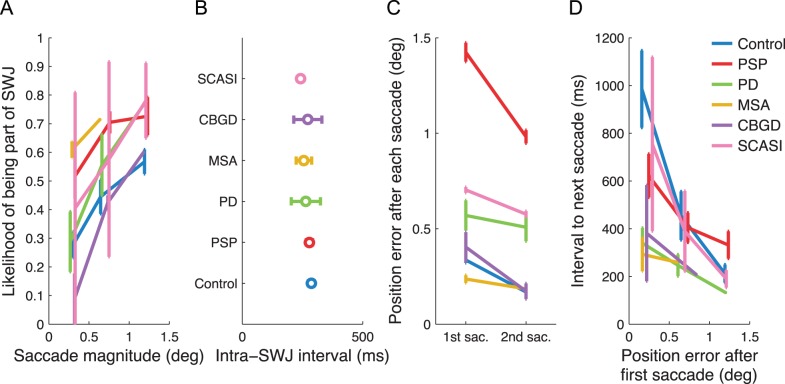
A common square-wave coupling mechanism.A) Correlation between saccade size and likelihood of being part of a SWJ. B) Intra-SWJ intervals across groups. C) Position error (see Methods for details) at the end of the first versus second saccade in a SWJ. D) Relationship between the estimated position error at the end of each saccade and the inter-saccadic interval to the next saccade. Error bars in all panels represent the standard error of the mean across subjects.